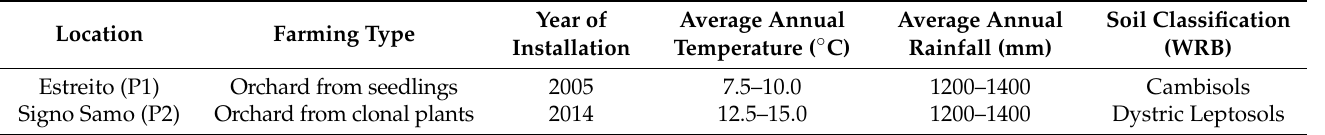
Table 1. Biophysical characterization of the experimental